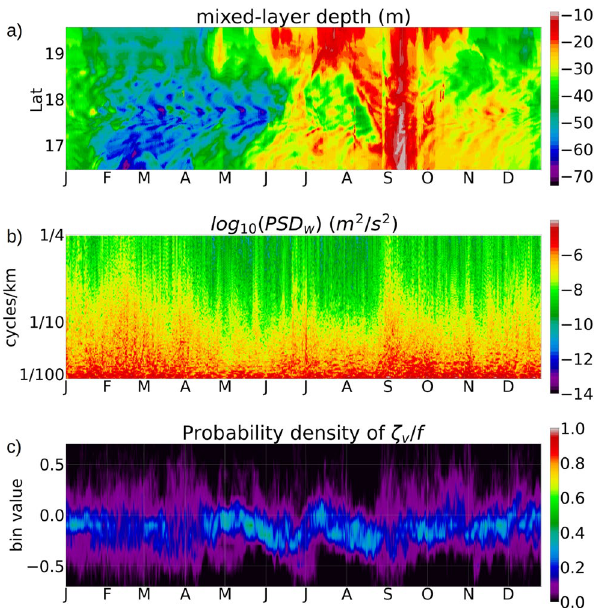
Figure 3. ( a ) Hovmöller diagram of the MLD along a north-south transect passing through longitude − 65.1 0 W , between St Thomas and Culebra. ( b ) Power spectral density (PSD) of the de-tided vertical velocity at −7 m depth along the north-south transect passing through longitude − 65.1 normalized vertical relative vorticity ζ v / f , computed from the de-tided current velocities at −7 m depth, along the same transect. The y axis shows the minimum value of each bin, and the bin size is